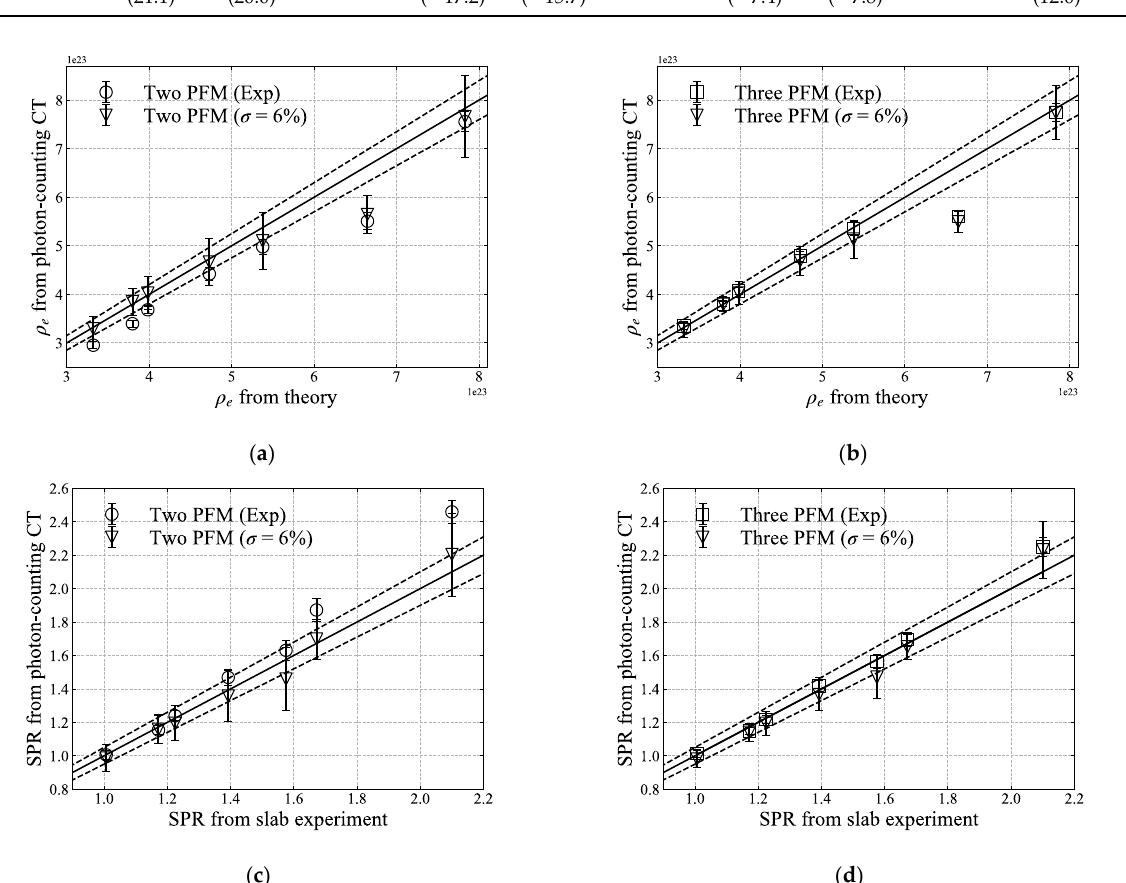
Figure 11. Comparison of ( a ) effective atomic number, ( b ) electron density, ( c ) I -value, and ( d ) SPR calculated via two- PFM and three-PFM with theoretical values. Solid lines indicate the same values for x- and y-axes, and the dotted line represents the error level of 5% for the solid line. Standard deviations are plotted together for each value. For the values here, regions of interest (ROIs) were set corresponding to the size of each rod sample in Figures 9 and 10, and the mean and standard deviation were calculated.